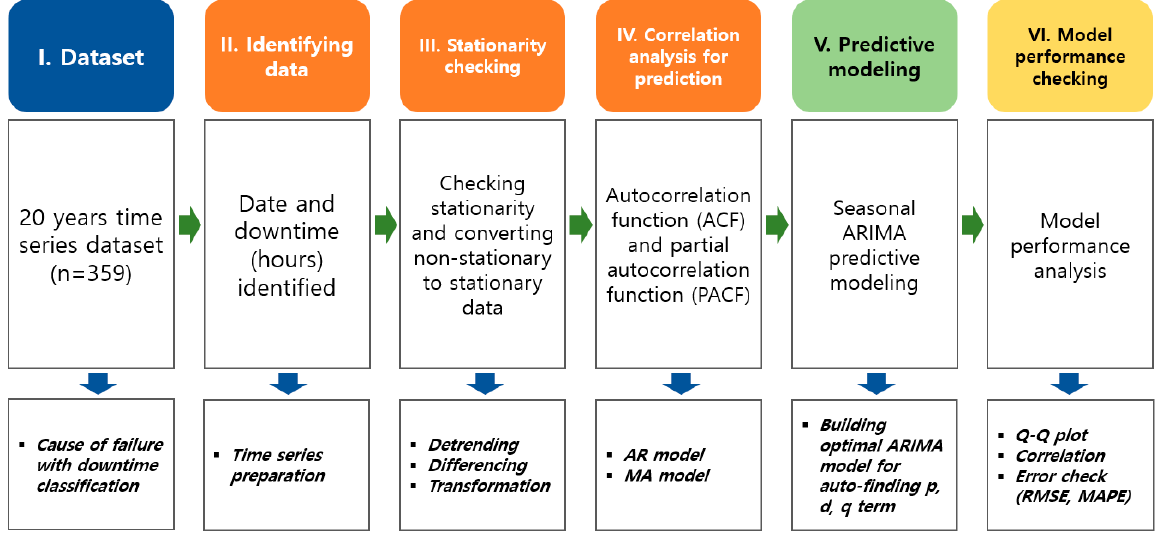
Figure 1. A research flowchart for descriptive time series analysis for LINAC maintenance records. Failure instances ( n = 359) were collected over time, and an ARIMA model was adopted for predictive modeling. AR, autoregression; MA, moving average; p, term for the number of AR; d, term for the integration of AR and MA; q, the number of lagged forecast residual errors for MA; RMSE, root mean square error; MAPE, mean absolute percentage error.